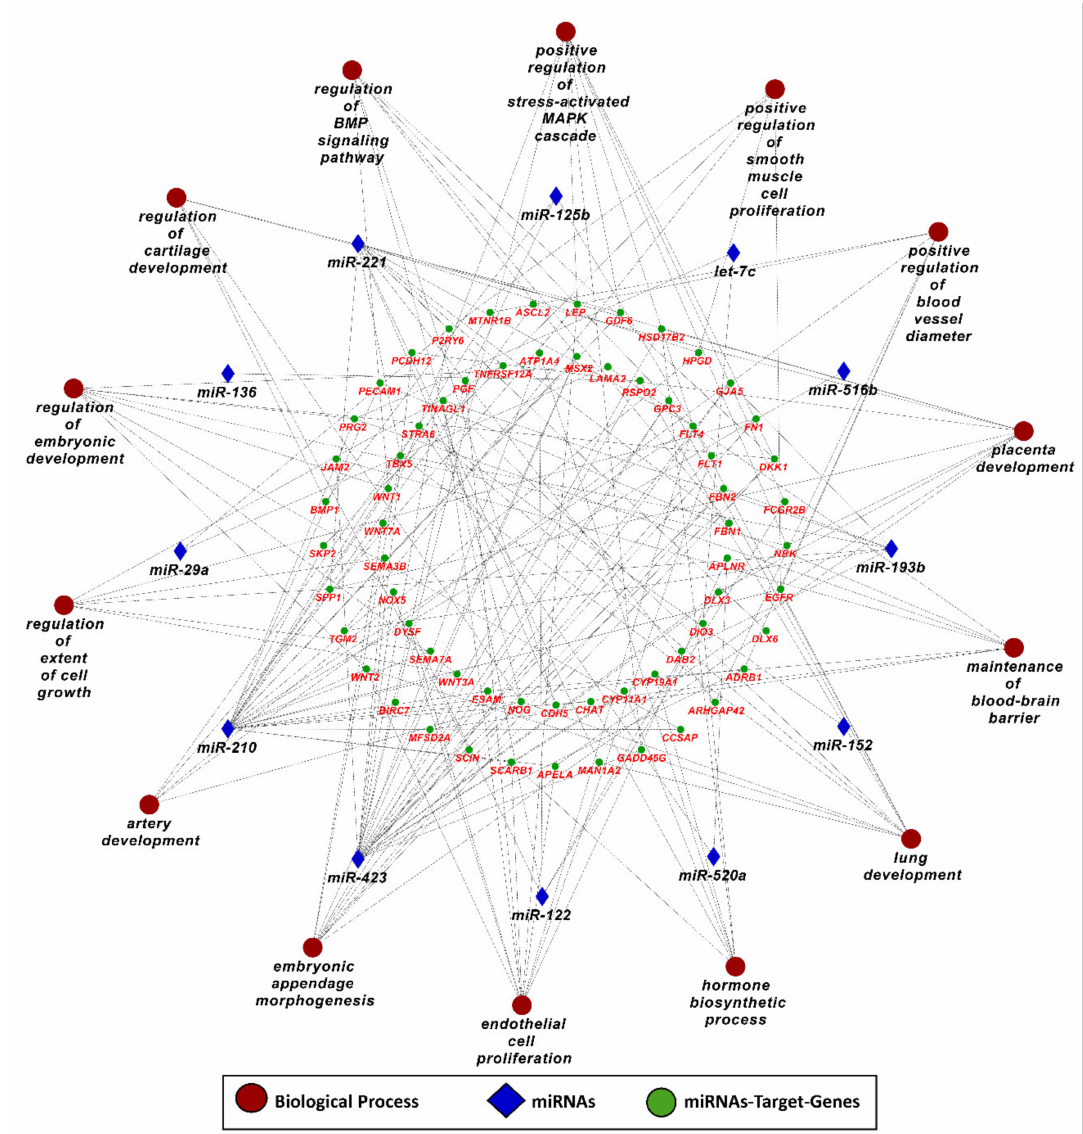
Figure 5. Gene ontology enrichment analysis for biological processes of target genes of PE-linked miRNAs from genes List 2, derived using ClueGO (version 2.5.1) and Cluepedia (version 1.5.7) plugin in Cytoscape (version 3.8.2) environment. A complete list of biological processes regulated by PE-linked miRNAs is provided in Table